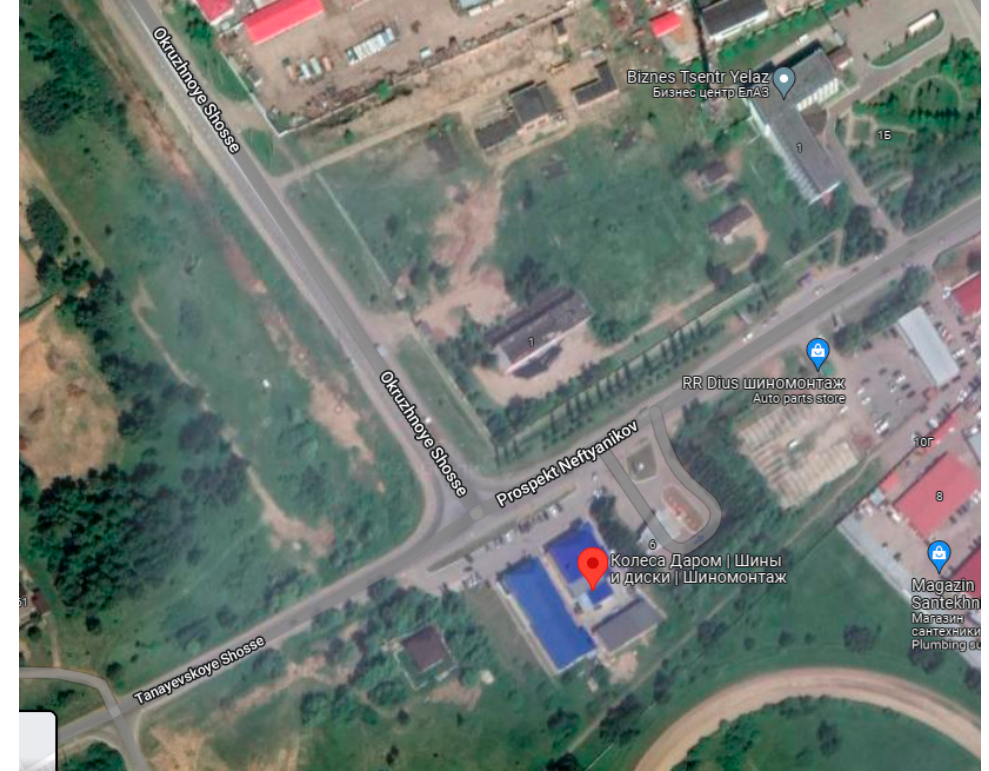
Figure 5. The intersection under consideration (adapted from opensource [37]).